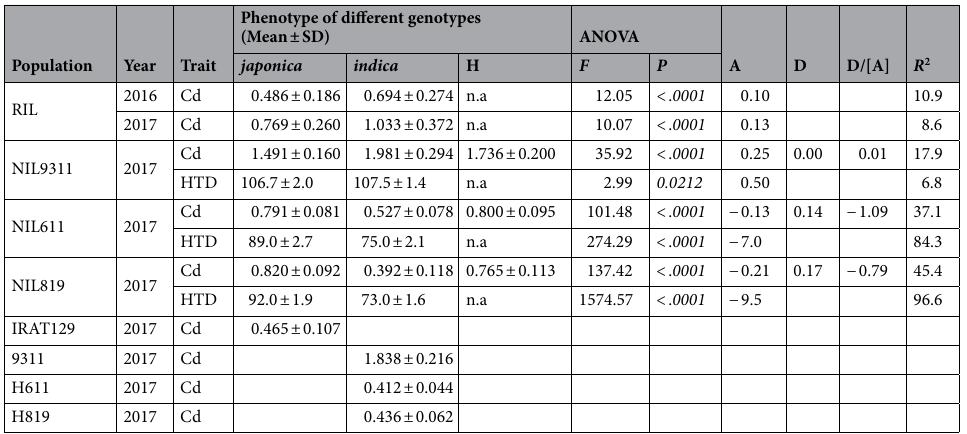
Cd concentration in 2016 and 8.6% of the variance in 2017. The OsHMA3 - OsNramp5 - OsNramp1 haplotype of IRAT129 appeared to be associated with decreased Cd concentration in brown rice. Validation of OsHMA3 ‑ OsNramp5 ‑ OsNramp1 jap effects in the indica genetic background. Three sets of NILs of OsHMA3 - OsNramp5 - OsNramp1 in an indica genetic background replaced with of 9311 (an elite